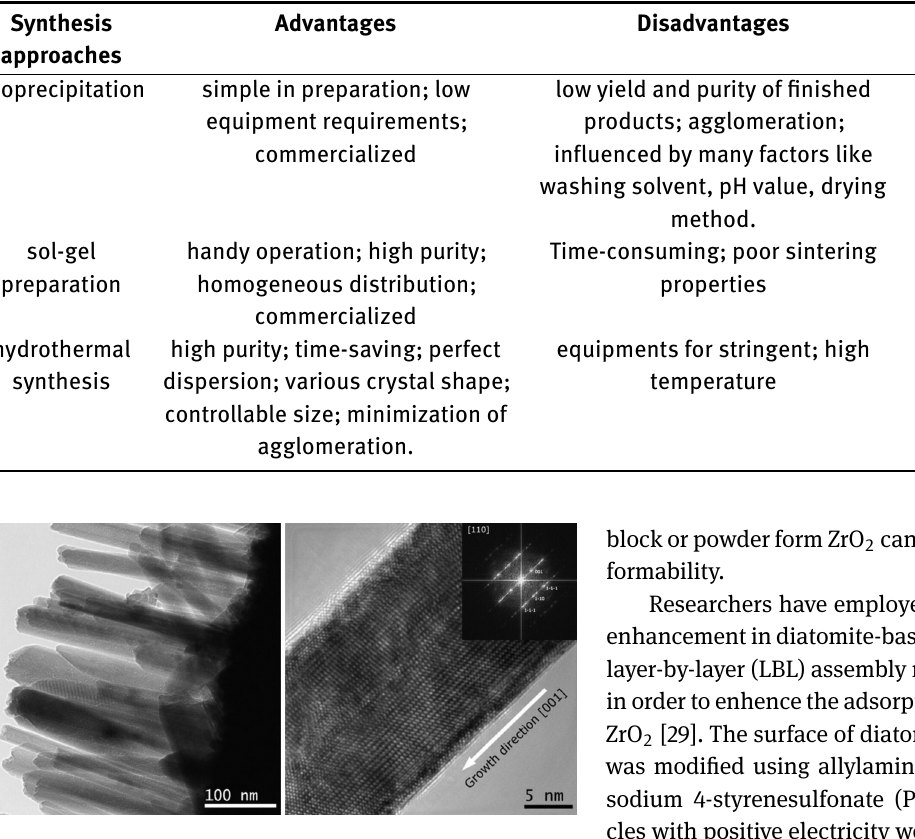
nanorods had diameters spanned from 25 to 200 nm and lengths ranging several hundred nm to 2µm (Figure